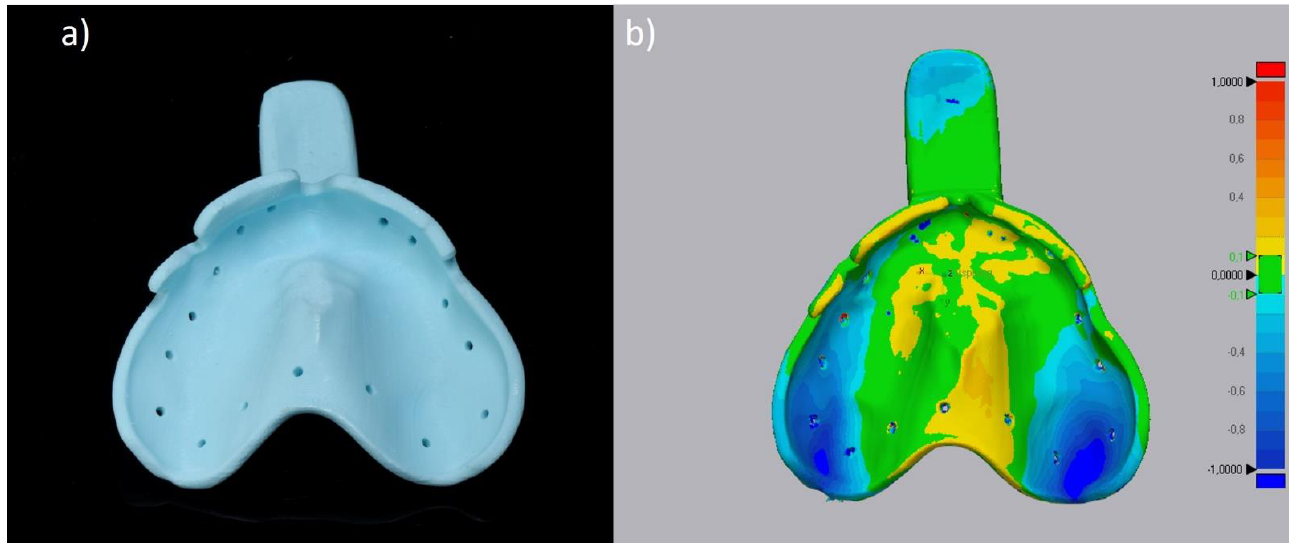
Figure 2 . ( a ) Customized impression tray fabricated by means of FFF (Filament: Trayfill), ( b ) Heatmap indicating the deviation between STL file and tray.